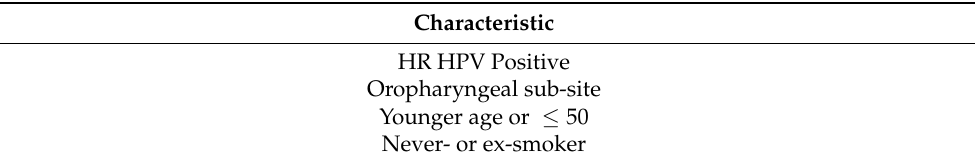
Table 12. Patient characteristics indicative of stereotypically HPV-driven oropharyngeal, oral cavity, and laryngeal SCC that may be the basis for the precise selection of patients for whom treatment de-escalation is